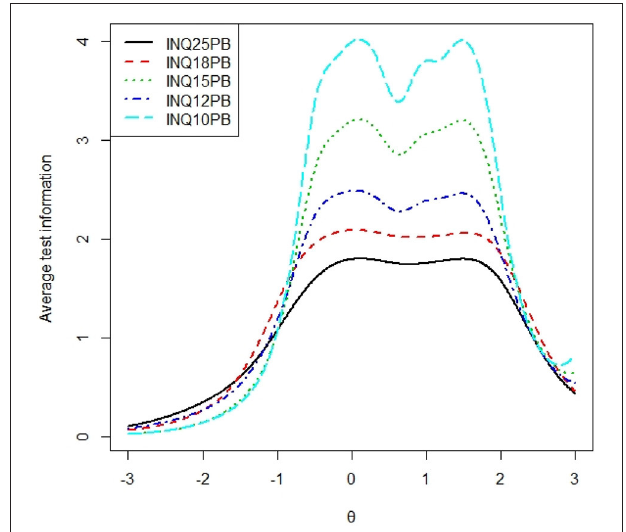
FIGURE 1 | Total test information curves of perceived burdensomeness of each version. INQ25PB, perceived burdensomeness subscale of INQ-25; INQ18PB, perceived burdensomeness subscale of INQ-18; INQ15PB, perceived burdensomeness subscale of INQ-15; INQ12PB, perceived burdensomeness subscale of INQ-12; INQ10PB, perceived burdensomeness subscale of INQ-10, same as below.